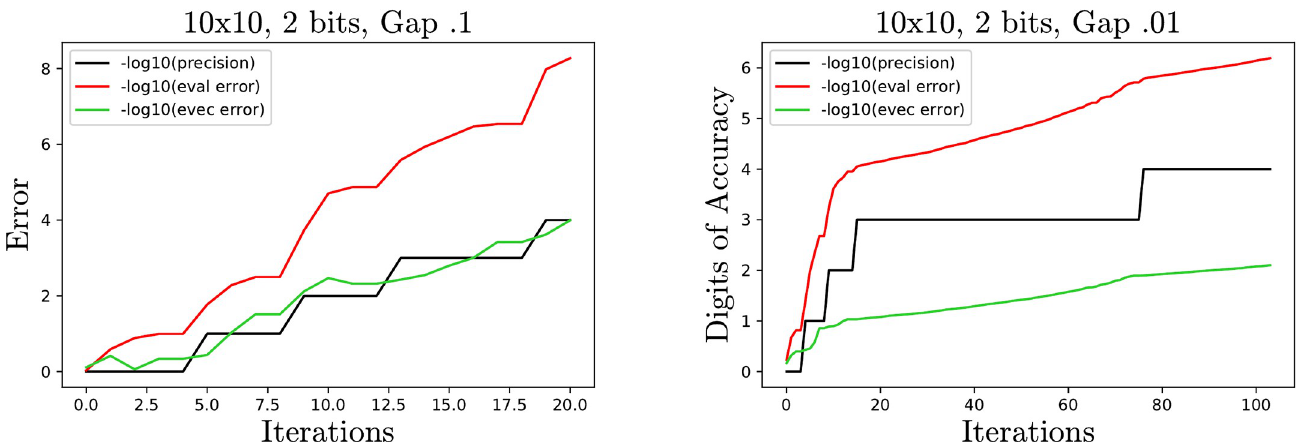
Fig 8. Sample plots for two 10 × 10 matrices with gap size .1 and .01. As the gap size decreases, the ratio of eigenvector error to precision and eigenvalue error increases.